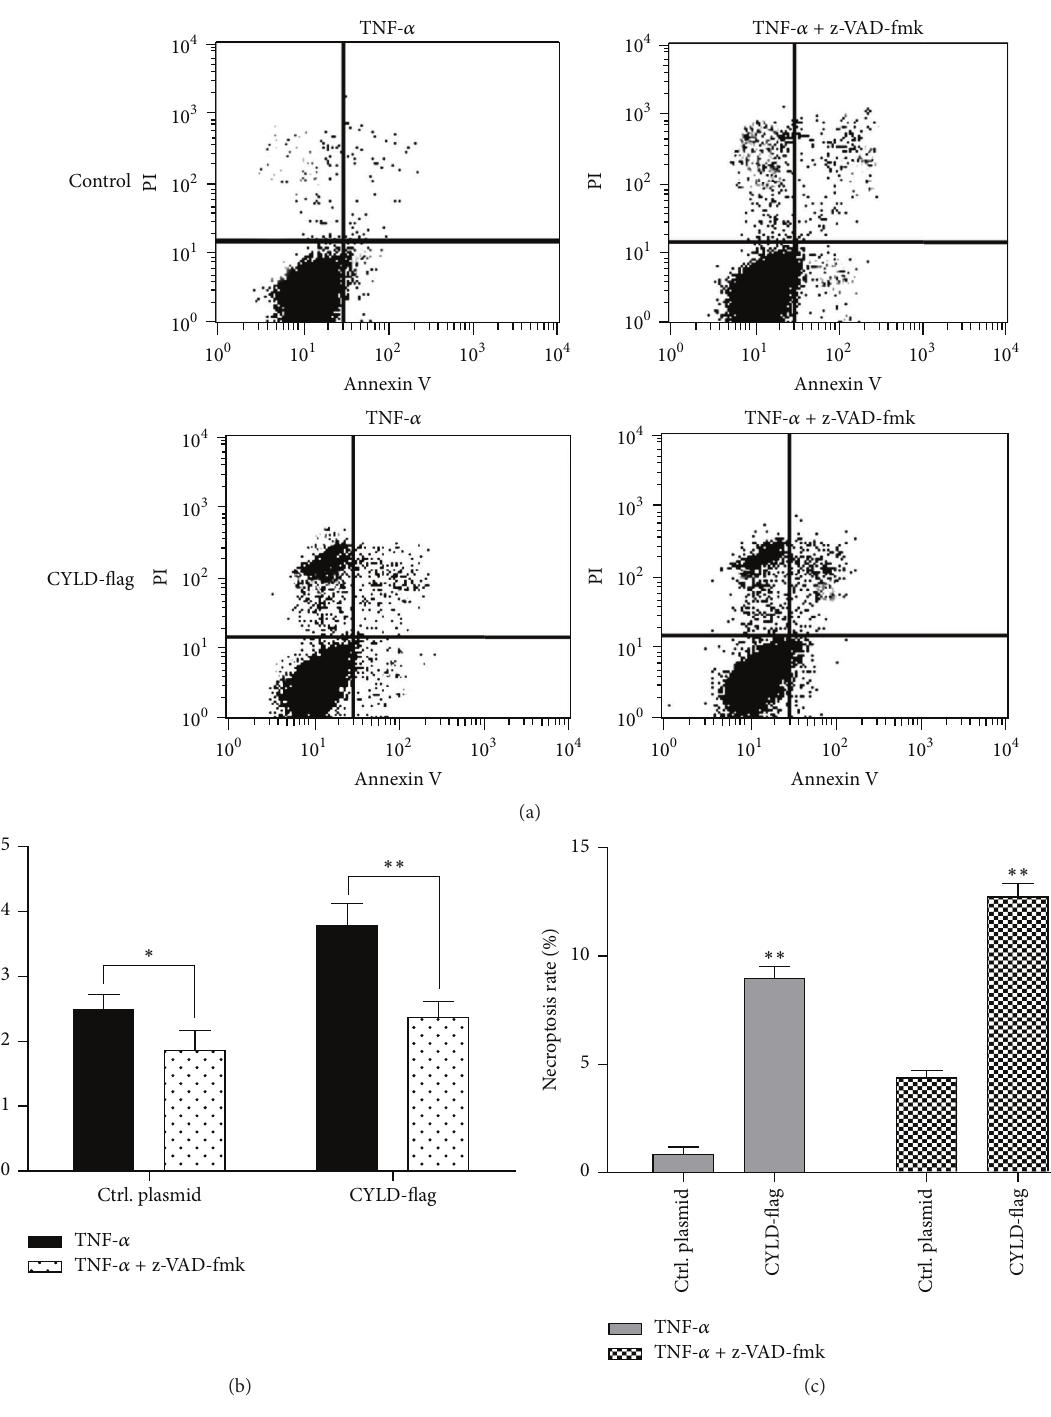
Figure 4: Overexpression of CYLD-flag induces cell necrosis of H460 cells. (a) Induction of apoptosis and necrosis was determined by Annexin V-PI dural staining. The A549 stable cell lines with CYLD expression and the control cell line were plated into 12-well plate and treated with 10ng/mL of TNF- 𝛼 alone, 20ng/mL of TNF- 𝛼 combinated with 10 𝜇 M of a pancaspase inhibitor, z-VAD-fmk for 12 hours. The 2 × 10 6 cells were collected and washed by PBS buffer. Annexin v-FITC/PI dual staining analysis was determined as the Material and Method. (b) The apoptosis rate of lung cells transfected with CYLD-flag or control plasmid was shown in histogram. ∗ 𝑝 < 0.01 , compared with control plasmid. ∗∗ 𝑝 < 0.01 , compared with N.C. siRNA group. (c) The necrosis rate was analyzed and shown in histogram. Values were mean ± SD. ∗∗ 𝑝 < 0.01 , compared with control